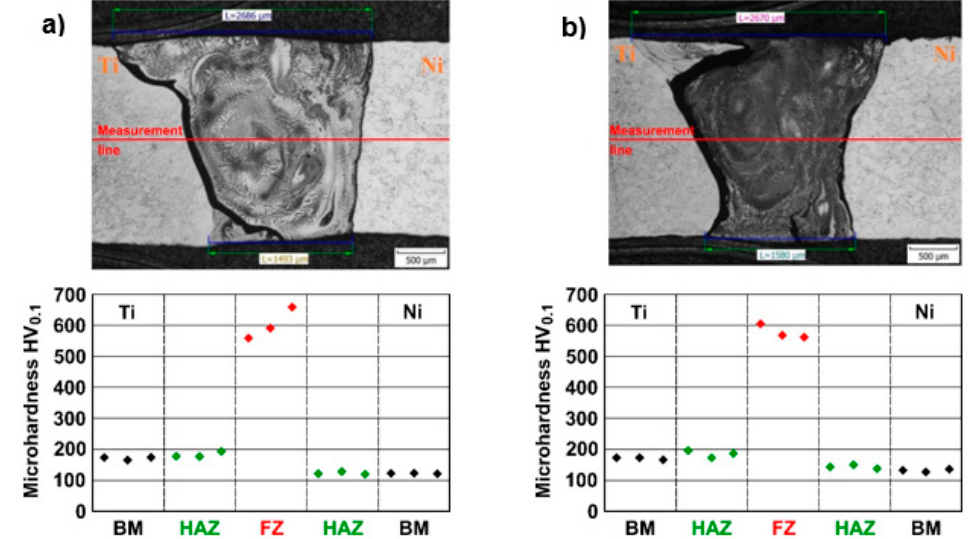
Figure 12. The distribution of microhardness across the Ti–weld metal–Ni interface of sample 8 ( a ) and sample 10 ( b ).